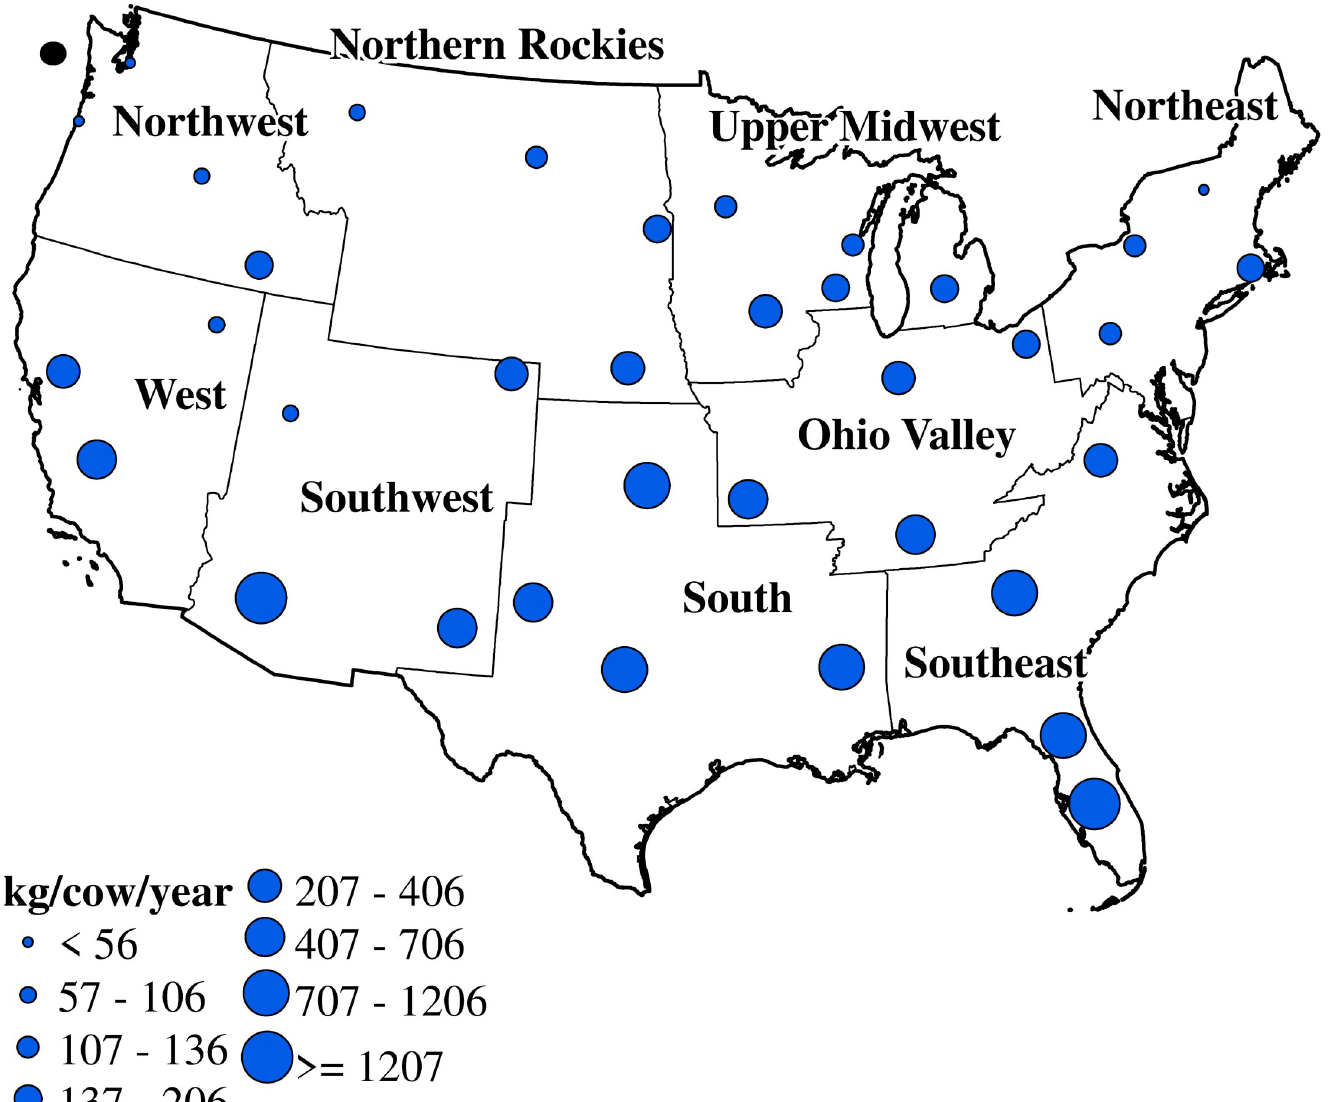
Fig 2. Late-20 th century average milk production loss per cow across the U.S. under Minimal heat abatement (Boundary data [31]).